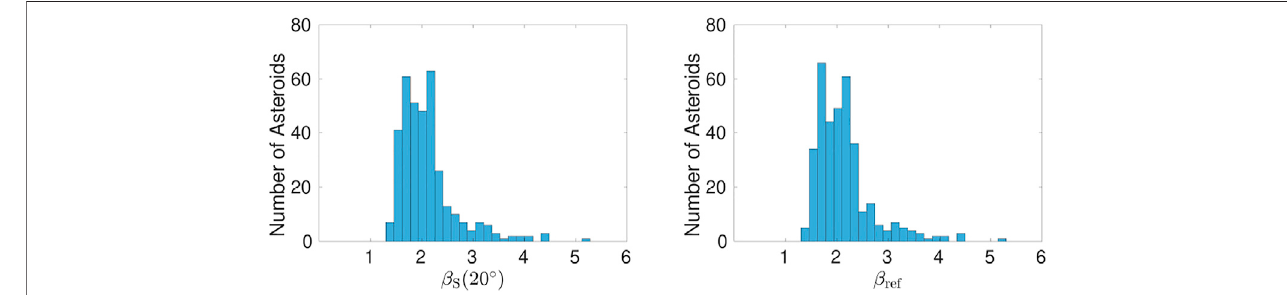
FIGURE 3 | Histograms of the derived β S (20 ° ) and β ref values (both in mag/rad), obtained using 358 asteroids.